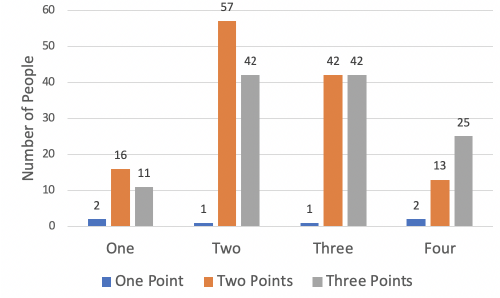
Figure 8. Responses about the characteristics of strong passwords. The x-axis is the password score from zxcvbn while each bar chart is the points value based on the participants’ response to three